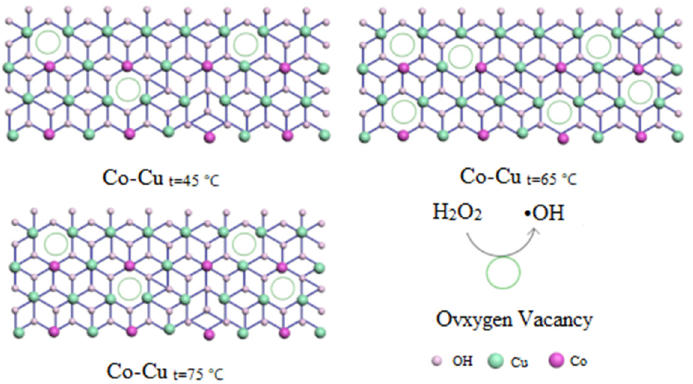
Figure 11. Structural model diagram of